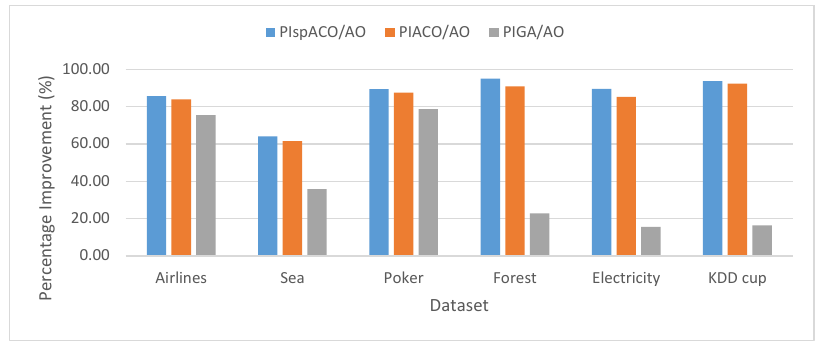
Figure 5. Analysis of PI for ER in different algorithms over IT2FCM-AO.